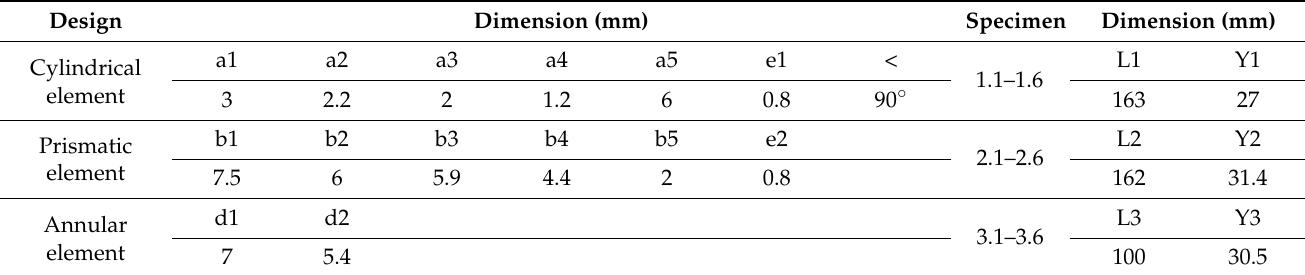
Table 1. Dimensions of unit elements and the